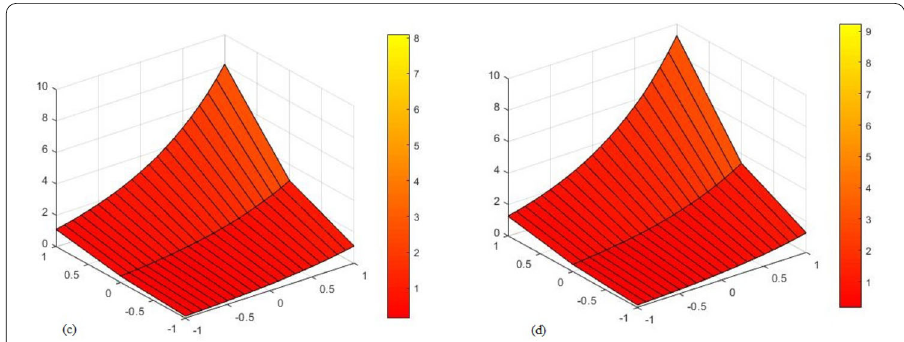
Figure 11 The graph of different approximate solution of (cid:13) ( χ , ϕ , η ) at ϒ = ( c ) 0.8 and ( d ) 0.6 of Example 2